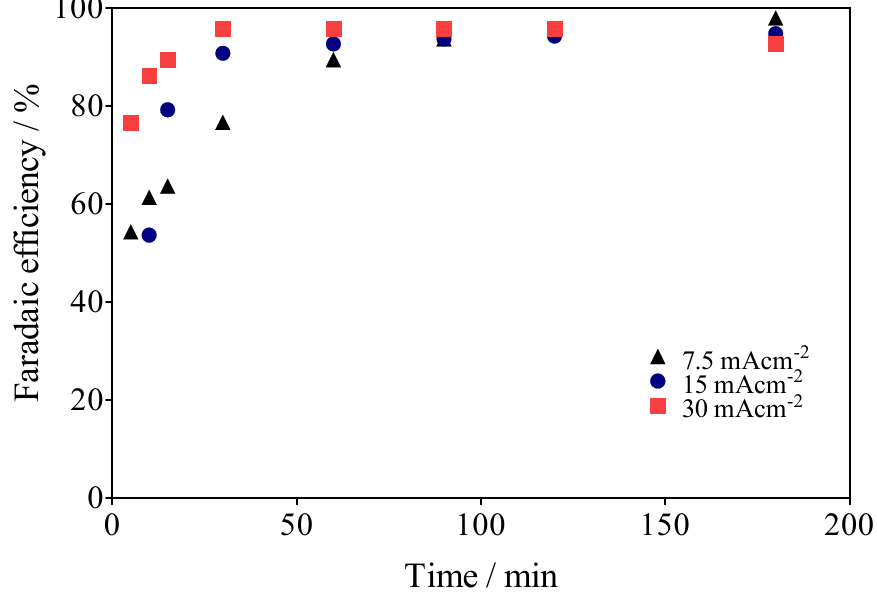
Figure 12. Faradaic efficiencies (in %) for data collected about the volume of H 2 in Figure 7. This last consideration is important in view of the economic/environmental sustain- ability of the system studied here, since it demonstrates that the use of renewable energies associated with electrochemical systems for advanced oxidation processes (AOPs) is a fea- sible hybrid approach to produce high added-value products, such as green H 2 . Therefore, both processes (depuration of water and energy vector production) are viable at costs of a fraction of traditional systems.